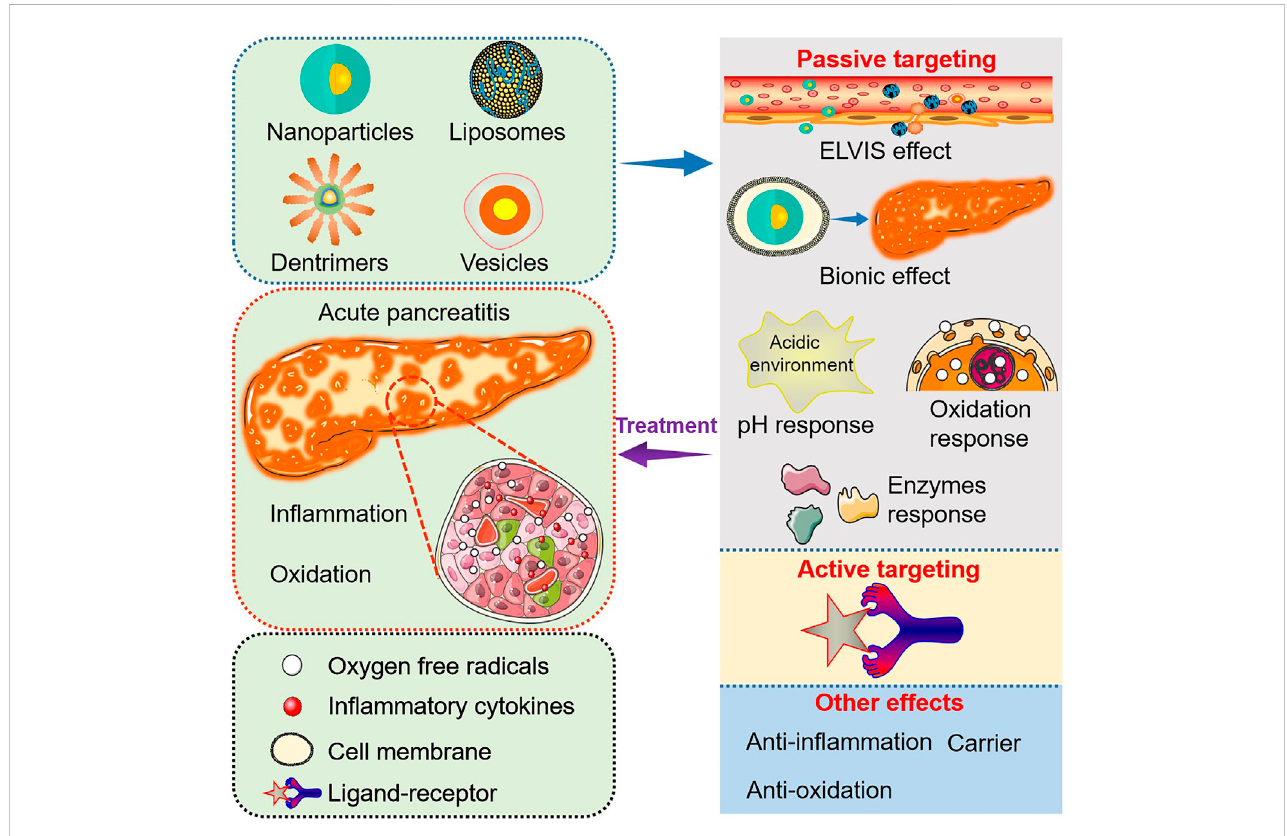
FIGURE 1 Targeting and functional effects of biomaterials-based nanoagents constructed speci fi cally for AP